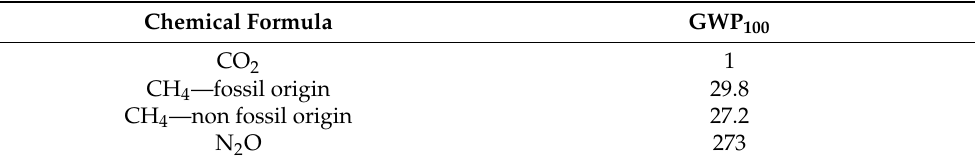
Table 1. GWPs of the most commonly considered greenhouse gases in the footprint analysis. Own elaboration based on [16].